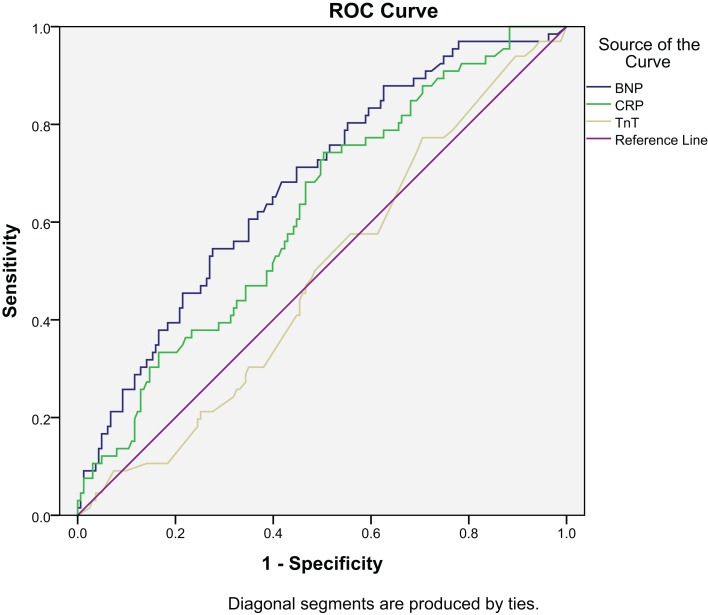
ROC for all-cause mortality at 2 years: BNP, CRP, and TnT.